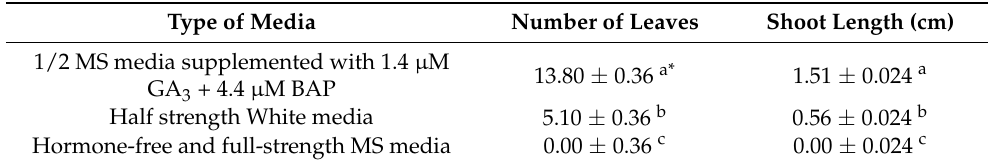
Table 1. Effect of different media types on direct shoot bud initiation from nodal explants (n = 10) after four weeks of in vitro culture of C. montanus